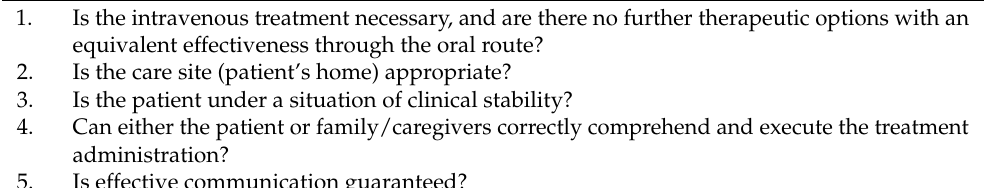
Table 3. Questionnaire to evaluate the adequacy of patient enrolment in an OPAT program. Adapted from